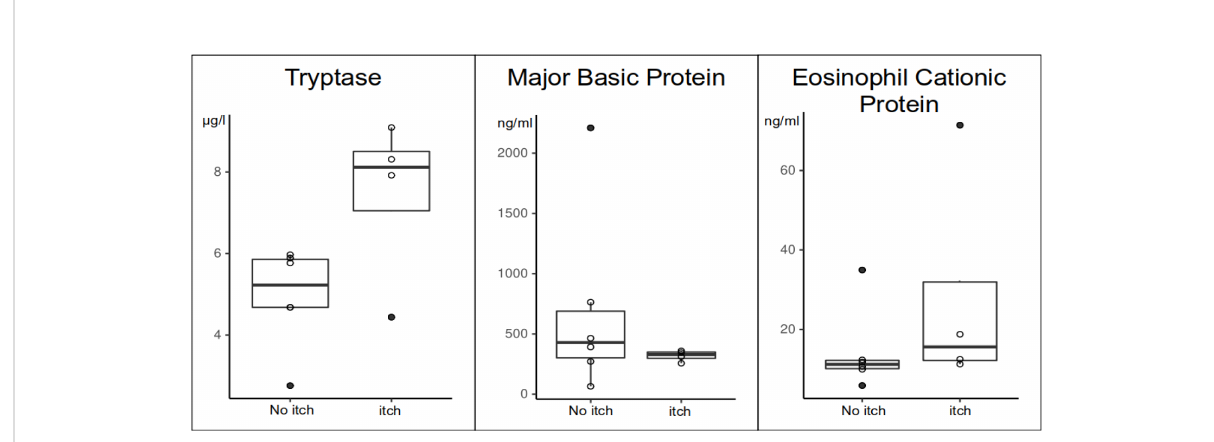
FIGURE 3 Differences of blood tryptase, MBP and ECP levels in MF patients with itch (itch) and without itch (no itch).